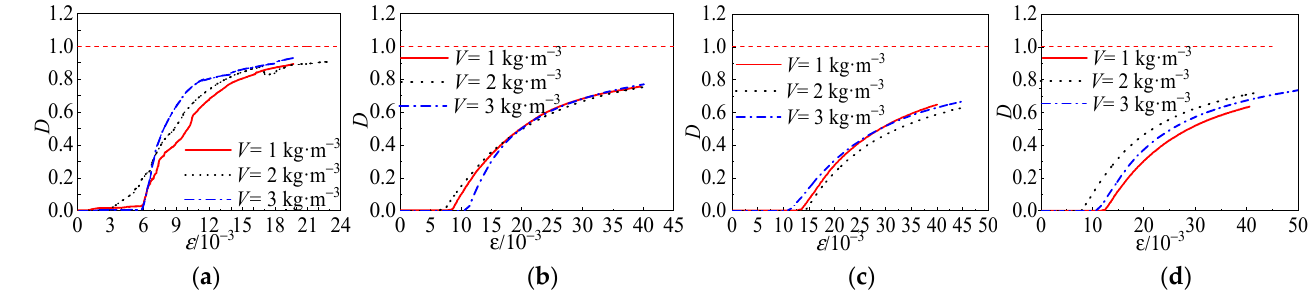
Figure 30. Effect of different variation parameters on damage: ( a ) σ w = 0 MPa, ( b ) σ w = 6 MPa, ( c ) σ w = 12 MPa, and ( d ) σ w = 18 MPa.